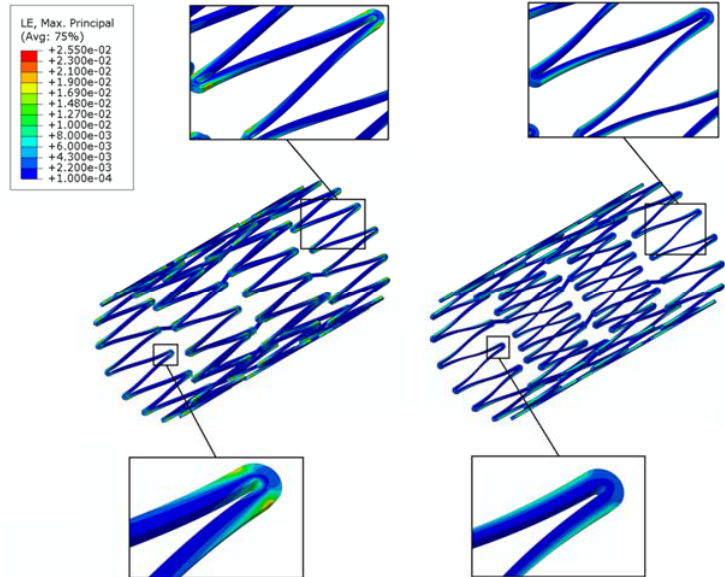
Figure 3. Finite element analysis (FEA) contour plot comparison of strain distribution between conventional stent ( left ) and tapered ‐ strut stent ( right ).